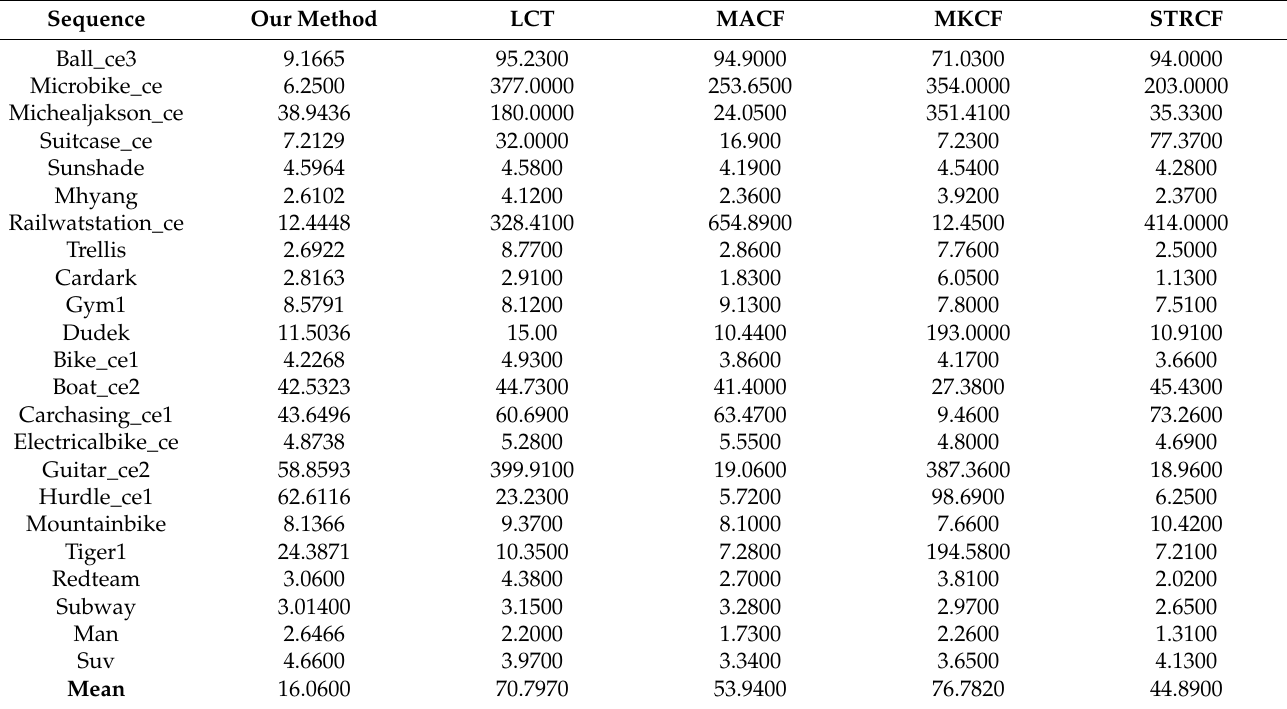
Table 4. Center location error of proposed method, LCT, MACF, MKCF, and